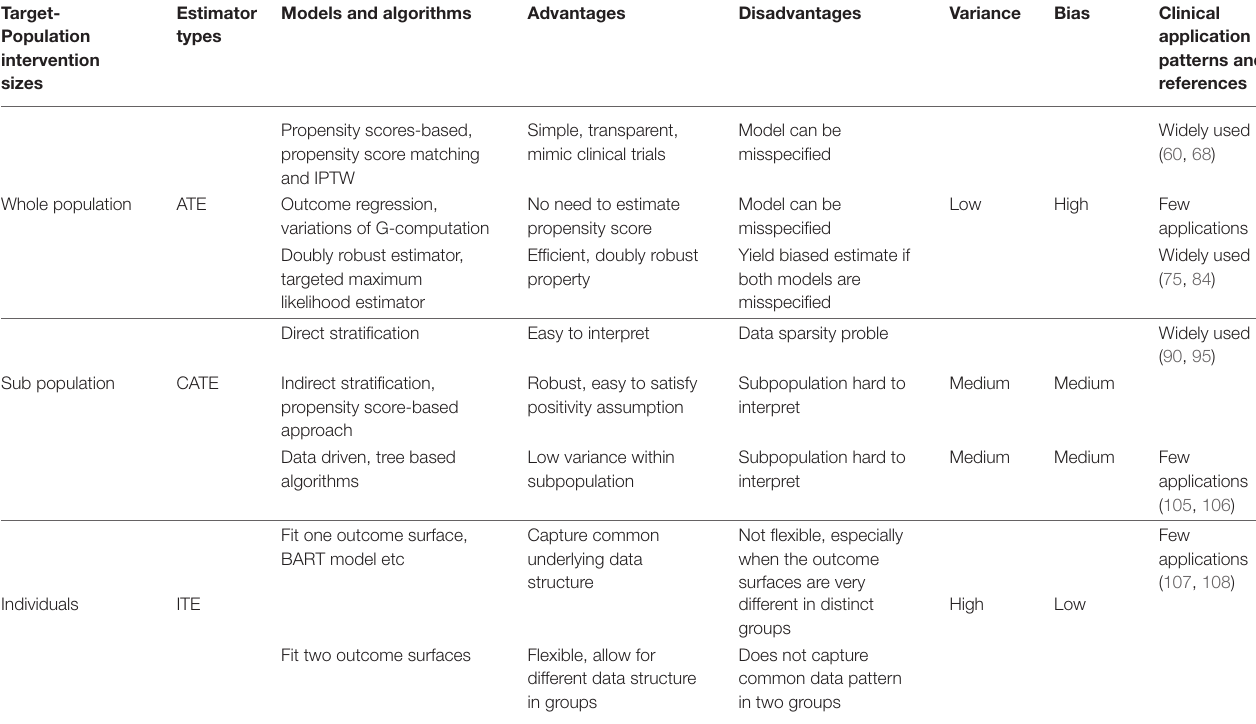
TABLE 1 | Summary of causal inference approaches in healthcare. Target-